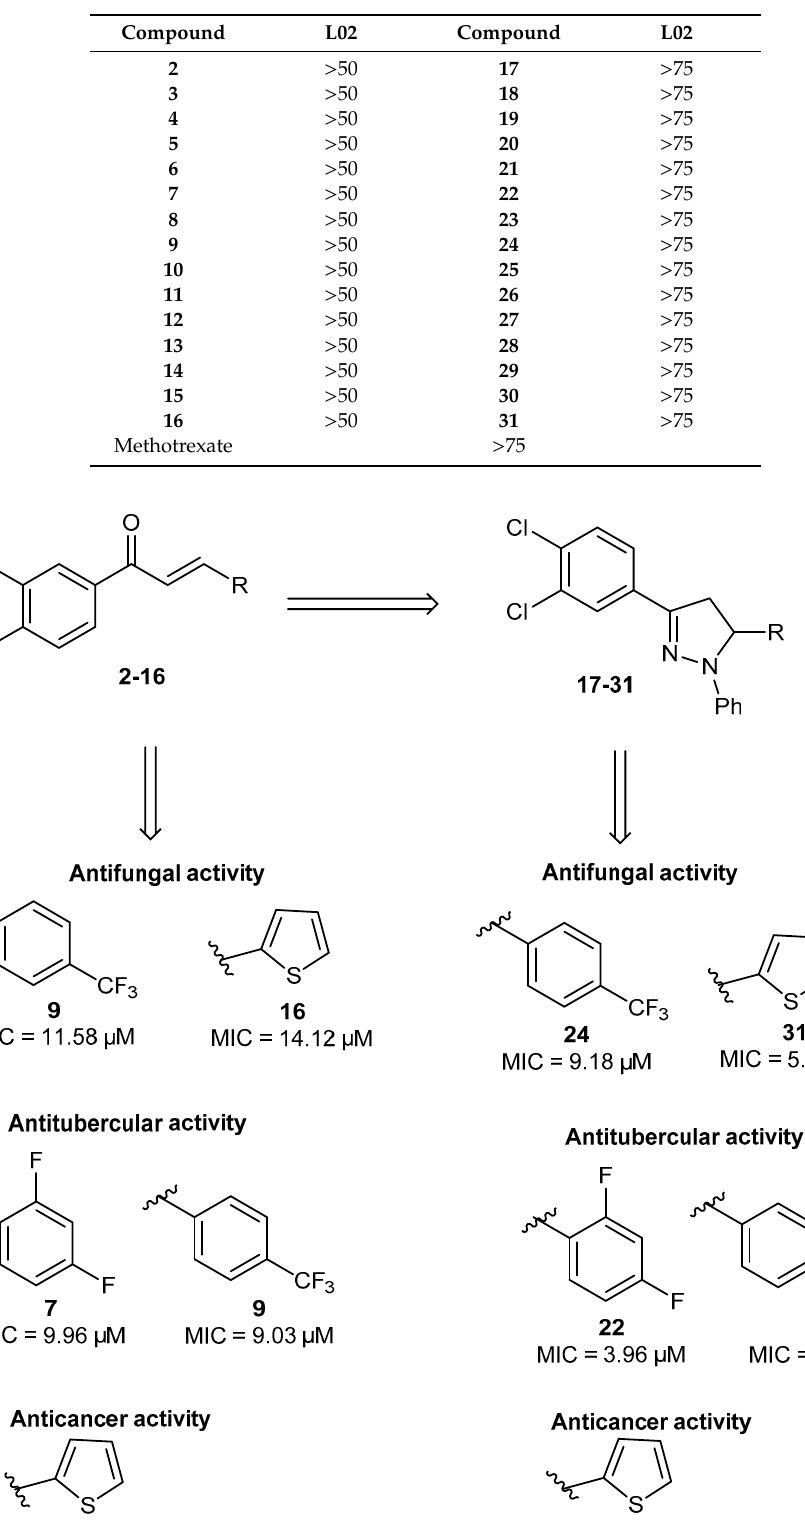
Table 4. Cytotoxic activity (IC 50 in µ g / mL) of chalcones ( 2–16 ) and dihydropyrazoles ( 17 – 31 ).